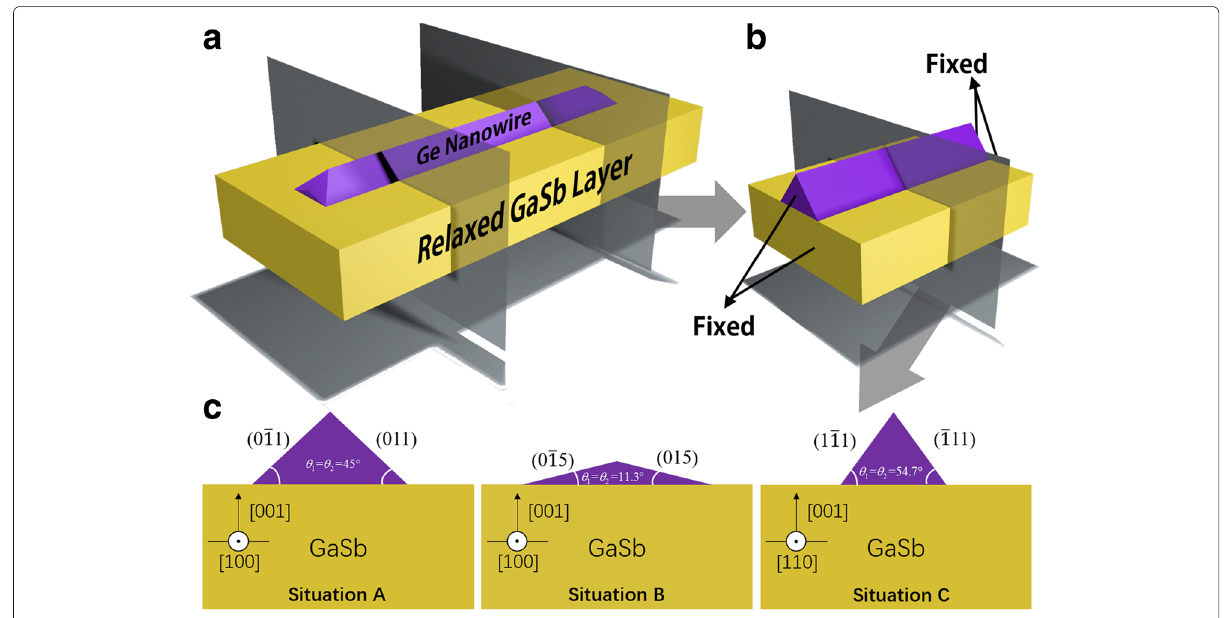
Fig. 1 Schematics of GeNW on GaSb: a 3D model, b simplified finite model, and c cross sections of GeNW with different facets